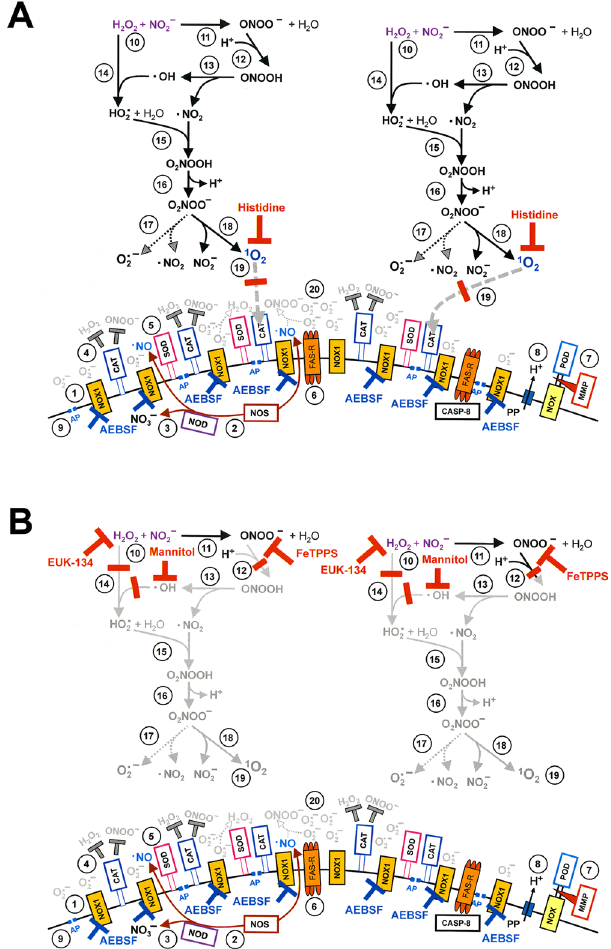
Figure 11. Elucidation of the action of primary singlet oxygen ( 1 O 2 ) directed towards membrane-associated catalase. ( A ) The NOX1 inhibitor AEBSF prevents the generation of secondary singlet oxygen ( 1 O 2 ). The singlet oxygen scavenger histidine (HIS) completely prevents inactivation of catalase by primary singlet oxygen ( 1 O 2 ) generated from long-lived species in PAM and thus ensures that singlet oxygen is the cause of inactivation in this scenario. ( B ) AEBSF prevents the generation of secondary singlet oxygen ( 1 O 2 ). The addition of either the catalase mimetic EUK-134, or the hydroxyl radical scavenger mannitol (MANN) or the ONOO − decomposition catalyst FeTPPS prevent the generation of primary singlet oxygen ( 1 O 2 ) derived from long-lived species in CAP-treated medium (#11-#19). Inhibition by these compounds discriminates between primary singlet oxygen generated through interaction between long-lived species in PAM and primary singlet oxygen that is directly derived from the gaseous phase of CAP. Supplementary Figs 11–13 show details of the detection of singlet oxygen directly derived from